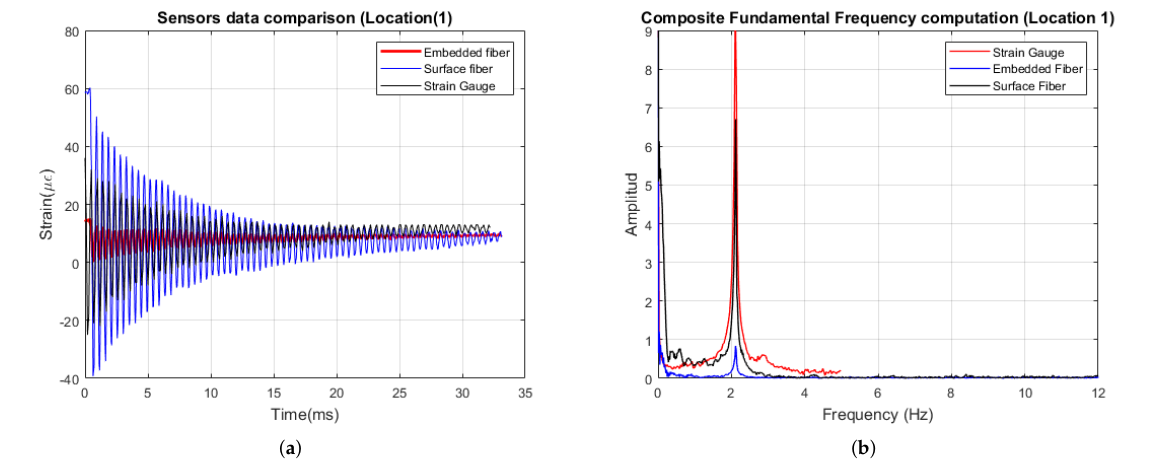
Figure 5. ( a ) Dynamic response response at location 1. ( b ) Frequency